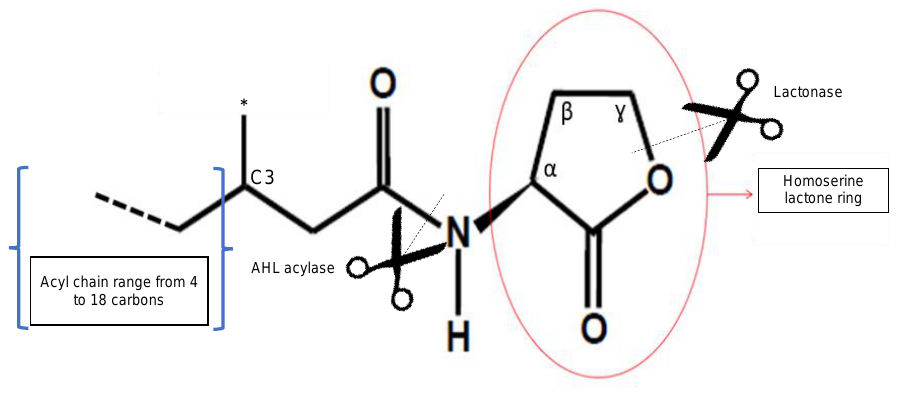
Figure 1. General structure of the N -acyl-homoserine lactone (AHL). A fatty acyl chain is linked to an homoserine lactone ring through an amide bond at the α position. The acyl chain ranges from 4 to 18 carbons in length and varies in its degree of saturation, oxidation, or substitution at the third carbon of the chain. Turnover of the QS mechanisms involves the degradation of AHL using lactonases in Agrobacterium or AHL acylase in P. syringae and R. solanacearum.